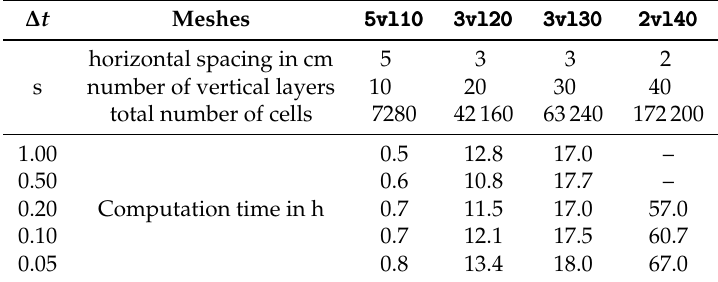
Table 3. Computation time for Case D of the lock exchange experiment on different meshes and with different time steps.